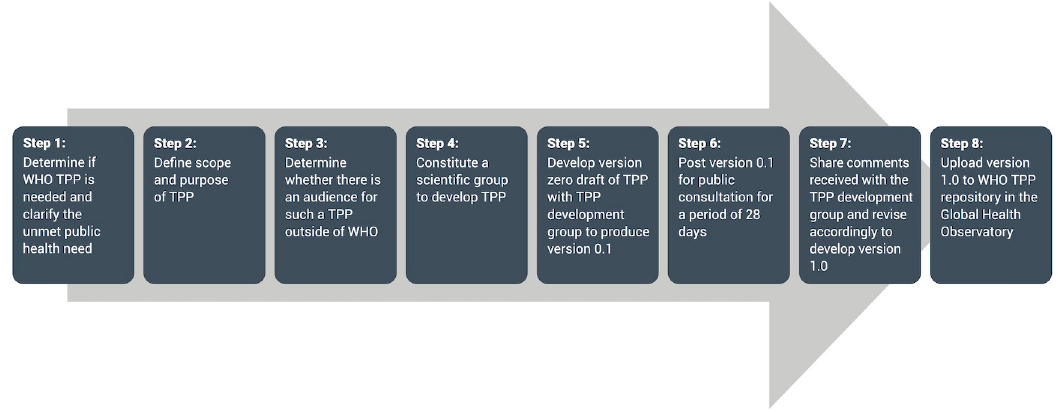
Fig 1. World Health Organization Target Product Profile